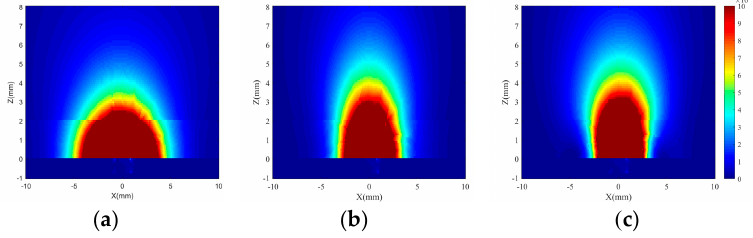
Figure 4. Simulated volume loss density (W / m 3 ) in the plane Y = 0 of the asymmetric Jerusalem cross antenna, fed by a power of 1 W at ( a ) 2 GHz, ( b ) 3 GHz, and ( c ) 4